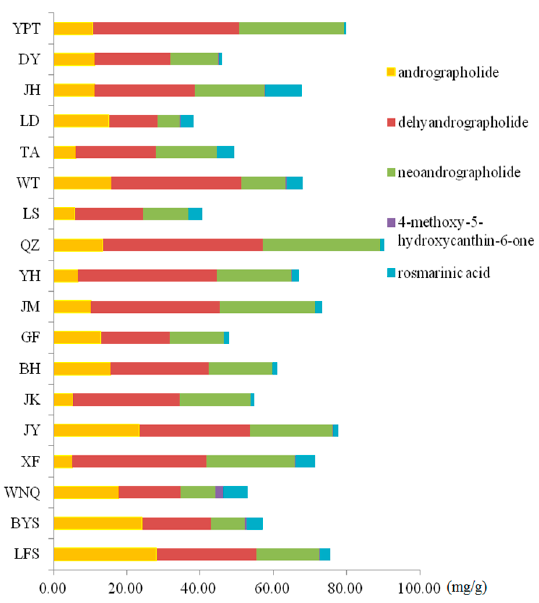
Figure 5. The bar graph of the average concentrations of five components in samples from 18 manufactures.